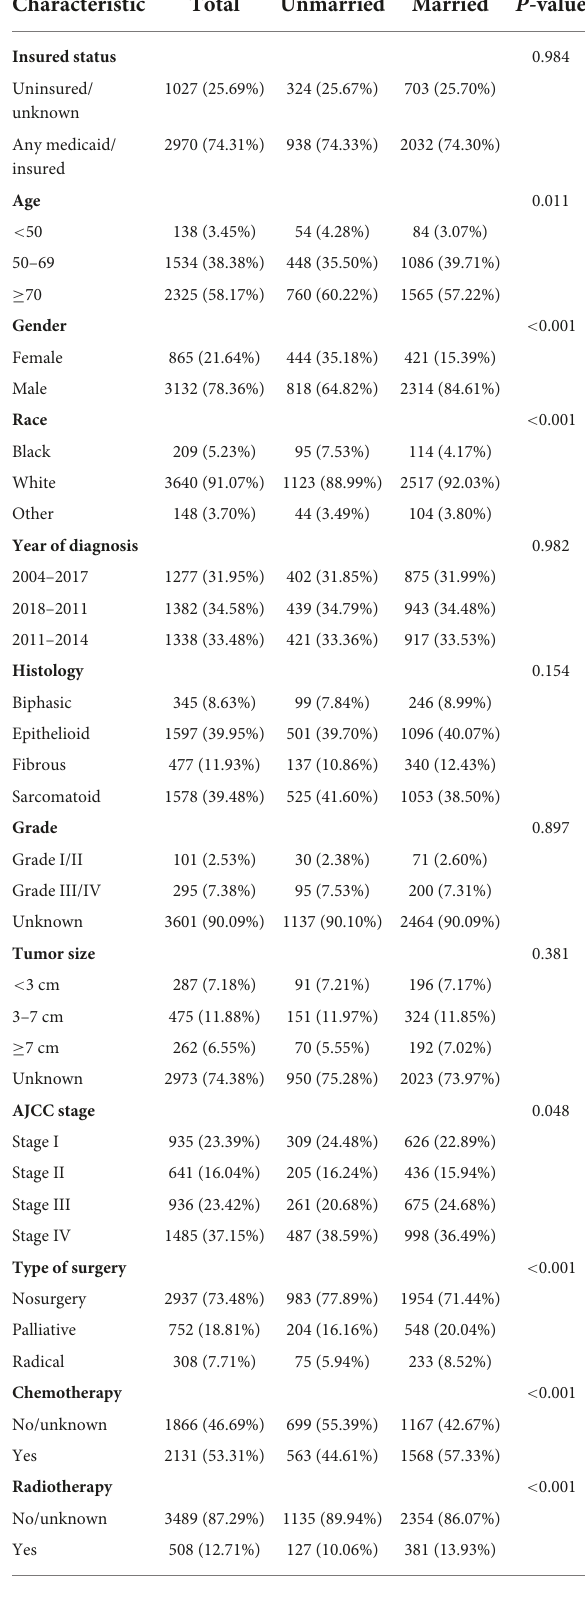
TABLE 1 The clinicopathological characteristics and treatments of the included 3,997 malignant pleural mesothelioma (MPM) patients.